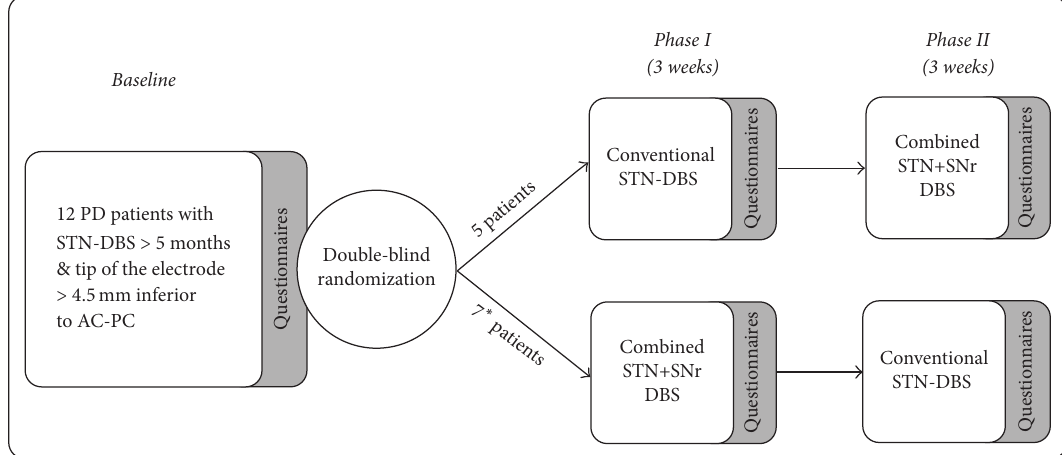
Figure 2: Study design: randomized cross-over trial over 6 weeks. After baseline assessment, PD patients were assigned in phase I to either conventional STN-DBS or combined STN+SNr stimulation. After 3 weeks, patients were switched to the other stimulation mode. ( ∗ ) Three of the 7 patients starting the phase I with a combined STN+SNr-DBS withdrew within the first